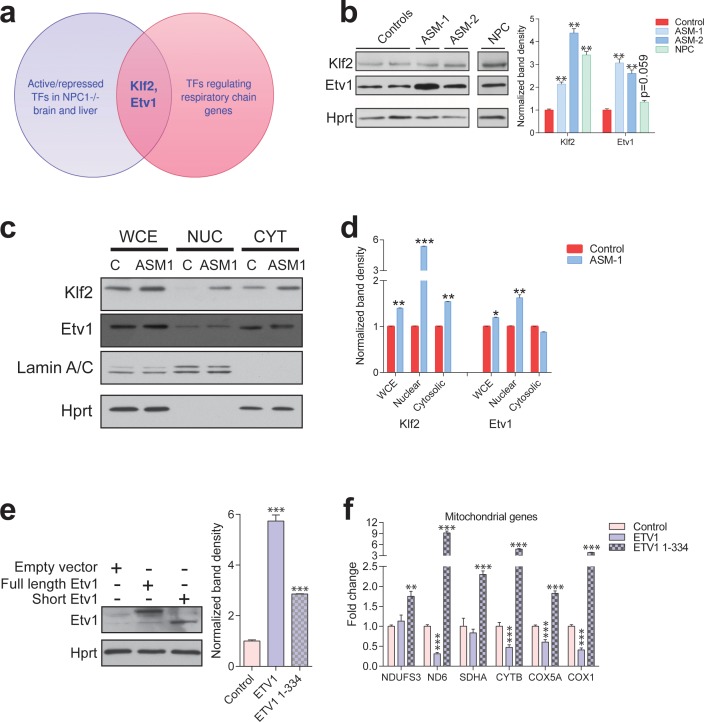
Transcription factors Etv1 and Klf2 are induced in Niemann-Pick and involved in the regulation of mitochondrial biogenesis.(a) Venn diagram illustrating the intersection between the list of transcription factors (TFs) that are significantly activated or repressed in tissues of Npc1-/- mice, and the list of TFs that are predicted to regulate the expression of mitochondrial respiratory chain genes, which yields KLF2 and ETV1 as hits. (b) Increased Klf2 and Etv1 protein levels in ASM-deficient and NPC fibroblasts, shown in a representative (out of three biologically independent experiments) western blot of whole cell extracts, with quantification (mean ± s.e.m., n = 3) of band densities in the adjacent plot. T-test p-values **p<0.01 (c) Increased nuclear localization of Klf2 and Etv1 in ASM-deficient fibroblasts. Blots are representative of biological triplicates with quantifications in (d) shown as mean ± s.e.m. T-test p-values *p<0.05, **p<0.01 and ***p<0.001 (e) Overexpression of ETV1WT (full length ETV1) and of ETV11-334, lacking the C-terminus which includes the DNA-binding domain. Representative western blot, quantification of band densities normalized to empty vector control from two independent experiments with two technical replicates each on the right panel (mean ± s.e.m.) (f) Overexpression of ETV1WT significantly down-regulates the transcript levels of most mitochondria-related genes, while ETV11-334, unable to bind DNA, causes an increase in transcript levels. The plots show mean ± s.e.m. T-test p-values **p<0.01 ***p<0.001, n = 2 with three technical replicates each.